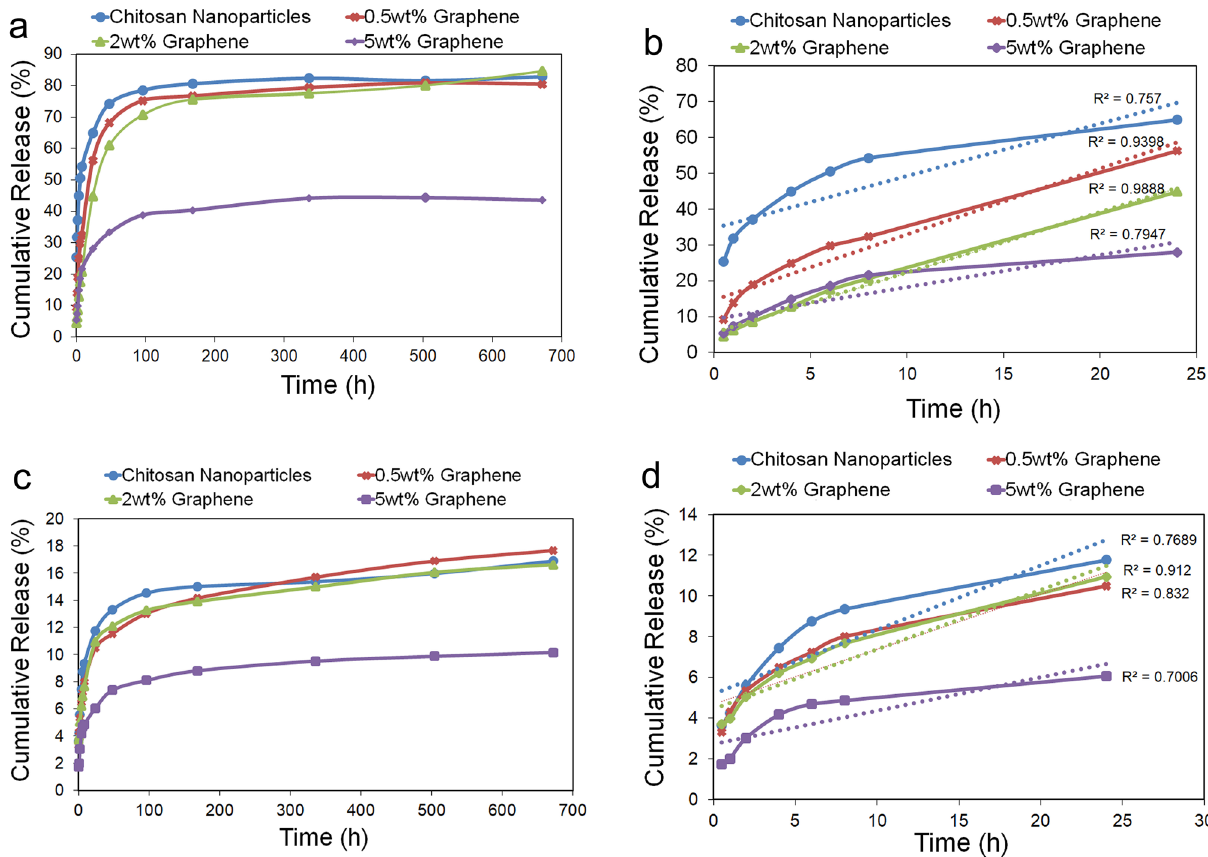
Figure 5. The release profile of DOX from the BSG/chitosan nanocomposite of 0.5, 2, and 5wt% BSG and its comparison with the curve of chitosan nanoparticles ( a ) at pH 4.5 within 28 days, ( b ) at pH 4.5 within the first 24 h. ( c ) at pH 7.4 within 28 days, ( d ) at pH 7.4 within the first 24